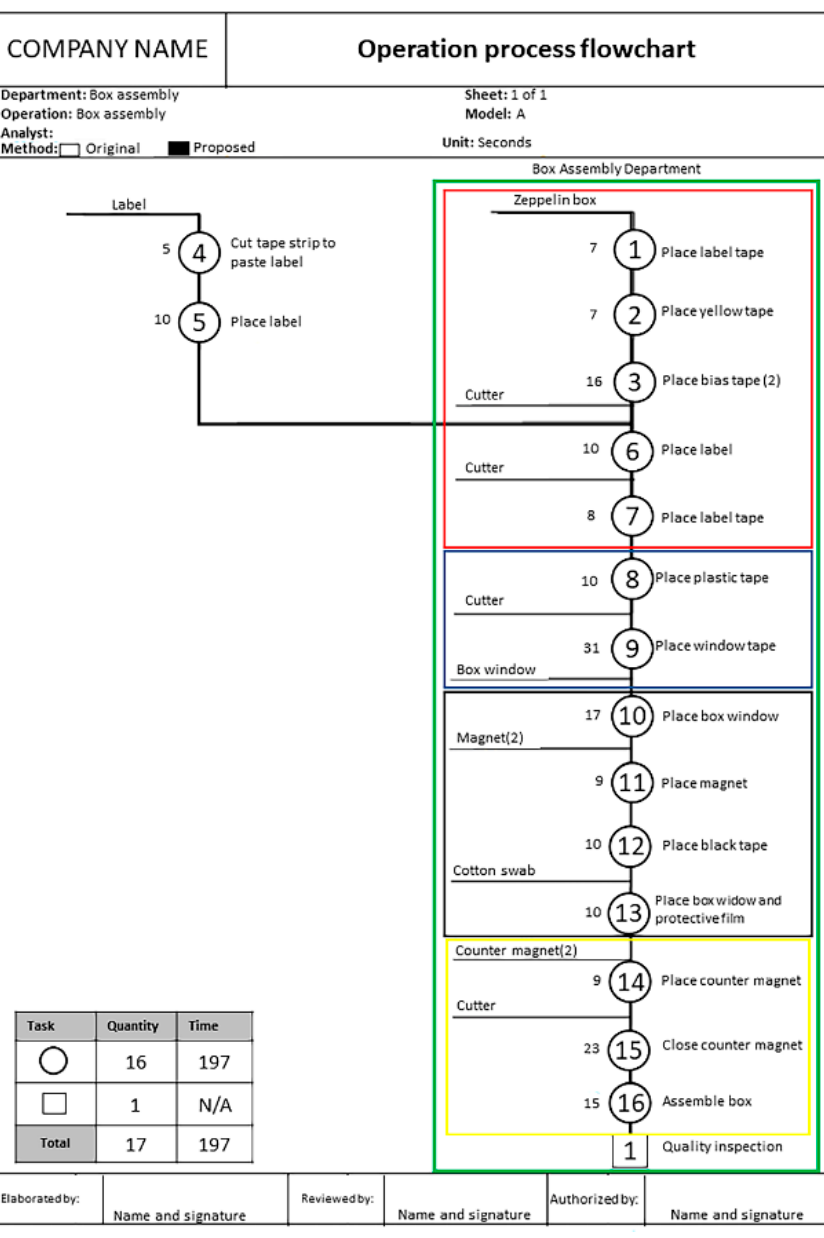
Figure 6. Flowchart process of the redesigned process.